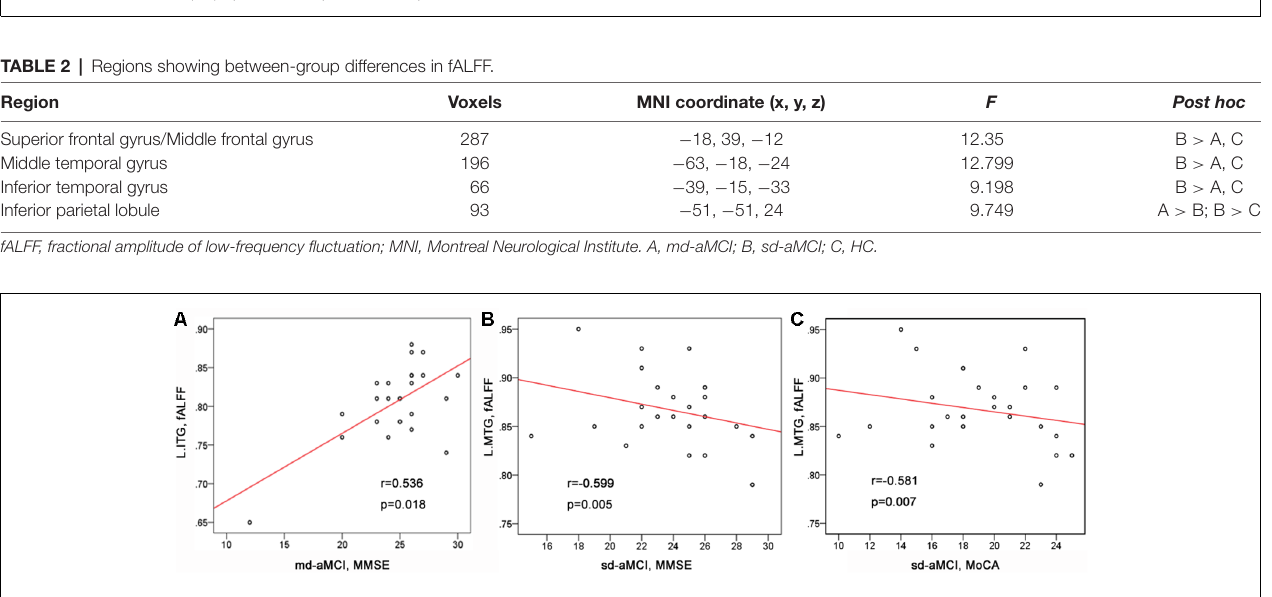
FIGURE 1 | Regions showing between-group differences in fractional amplitude of low-frequency fluctuation (fALFF). The images show a significant group effect on the fALFF in the left frontal gyrus, left middle and inferior temporal gyri, and left inferior parietal lobule. The numbers at the lower-left corner of the image refer to the montreal neurological institute (MNI) coordinates. The bar maps show between-group differences in fALFF in these regions. The data were expressed as mean value ± standard error (SE). * p < 0.05; ** p < 0.01; *** p < 0.001.